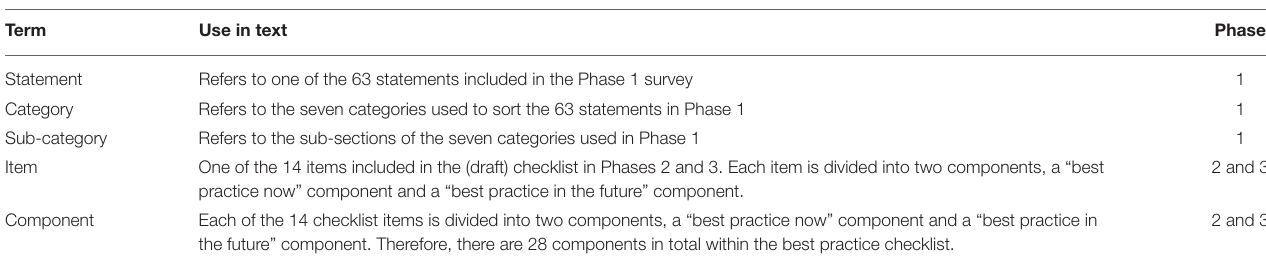
TABLE 2 | Terminology used to describe survey